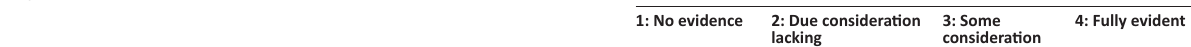
TABLE 1-A2: Model validation governance scorecard. Adequacy of governance